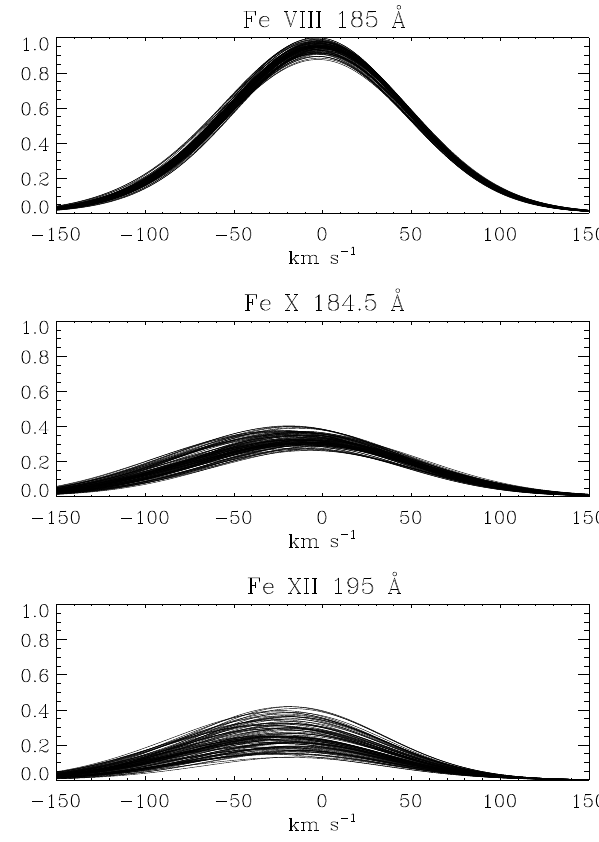
Figure 5. Synthetic line profiles, from a 5000s simulation, for a loop consisting of 10 strands. There is a 50s interval between each plotted line.